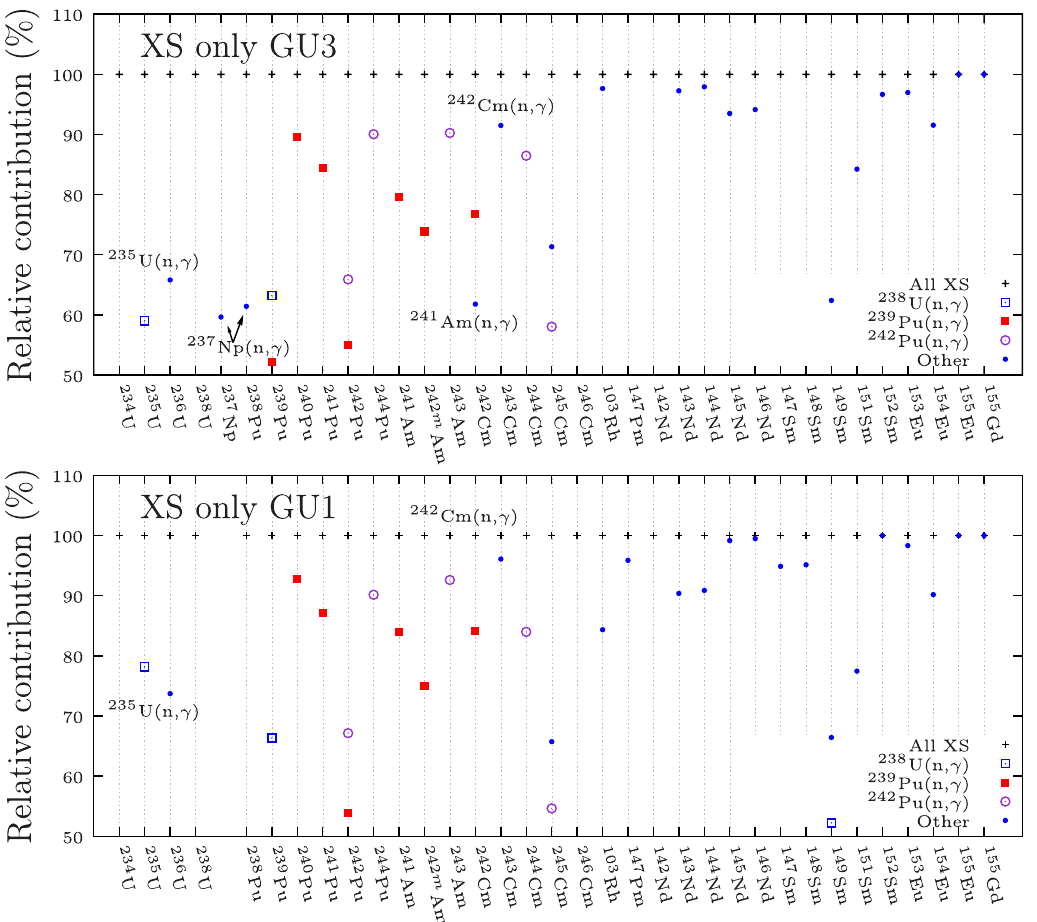
Fig. 7. Top: relative contributions of cross sections, nubar and fission spectra (called XS) to the total XS uncertainties for fission products and the GU3 sample. Bottom: same for the GU1 sample